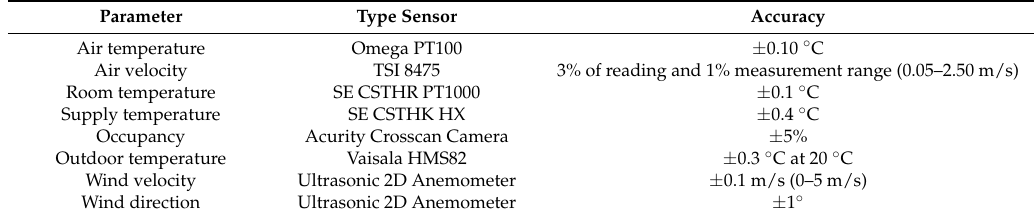
Table 3. Properties of the sensors.